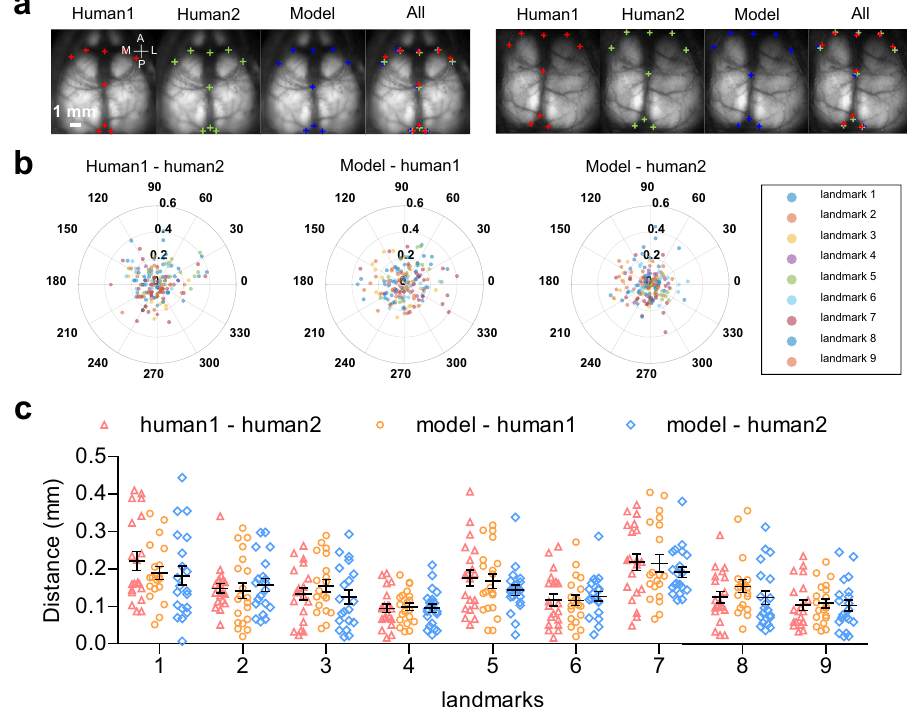
Fig. 2 Performance of automated landmark estimation. a Examples of model labelled and manual labelled landmarks on GCaMP images (denoted by ‘ + ’ symbols; blue, model labelled; red and green, manual labelled). b Polar plot of distance between coordinates of model labelled and manual labelled landmarks. c Comparison of distance between coordinates of model labelled ( n = 20 mice) and manual labelled landmarks ( n = 20 mice) and distance calculated by differences between coordinates of two runs of manual labelled landmarks ( n = 20 mice) (scatter dot plot, line at mean with SEM, Bonferroni tests (two-sided): human1 - human2 vs model - human1, p > 0.05; human1 - human2 vs model - human2, p > 0.05; model - human1 vs. model - human2, p > 0.05; mean distance and SEM for each landmark see Supplementary Table 2). Source data are provided as a Supplementary Data fi